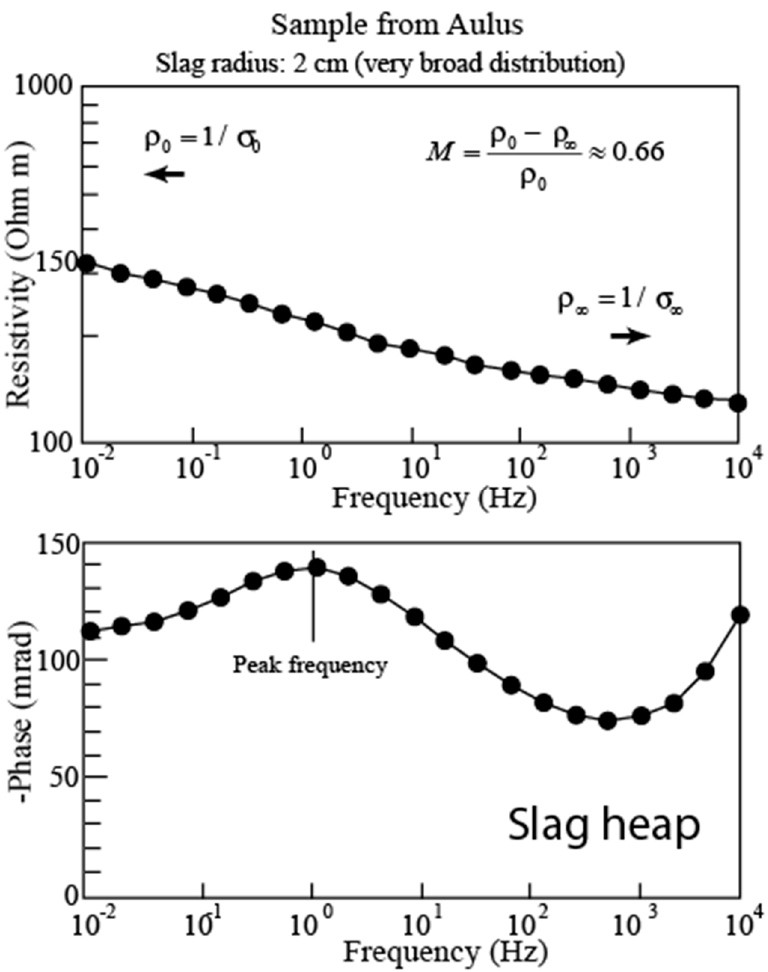
Figure 7. Complex resistivity spectrum (amplitude and phase) for a sample from a slag heap [17]. The particle ‐ size distribution of the metallic particles is broad, with a mean radius around 2 cm, which explains the occurrence of a low ‐ frequency peak in the phase. The chargeability ( M = 0.66 in the present case) is much higher than the chargeability of rocks and soils in the absence of metallic particles (usually smaller than 0.10). The lines are guides for the eyes. Modified from [64].